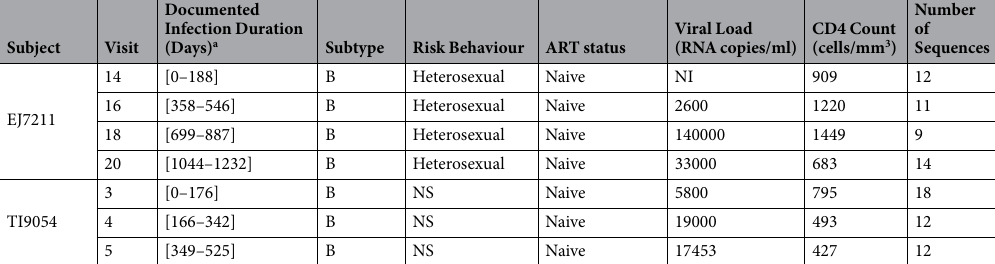
We collected and newly sequenced HIV envelope gene segments spanning part of V3 and entire V4 (HXB2 7134-7499). HIV envelope gene sequences have provided a more informative signature for incidence detection, as compared to HIV gag gene sequences 18, 19, 21 . We calculated each specimen’s incidence biomarker, the genome similarity index ( GSI ), as previously described 19 ,